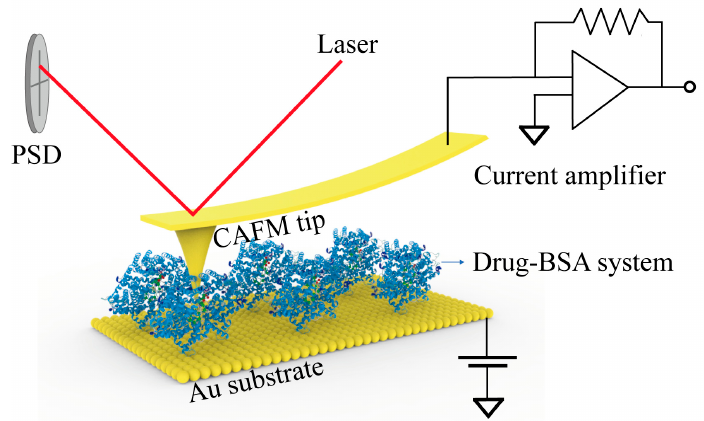
Figure 4. The schematic diagram of I-V tests.